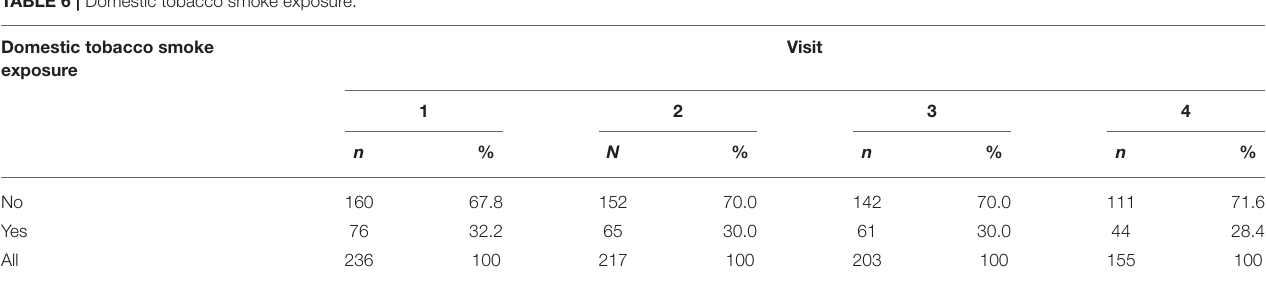
TABLE 6 | Domestic tobacco smoke exposure.